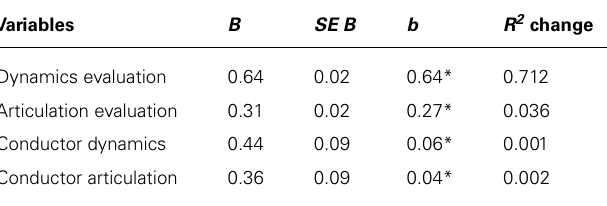
Table 3 | Summary of final regression model predicting expressivity